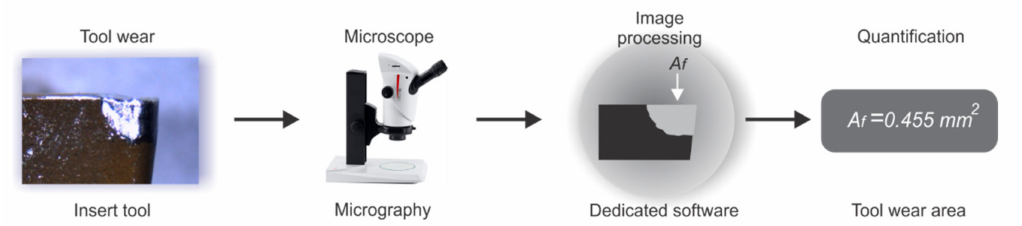
Figure 4. Tool-wear area